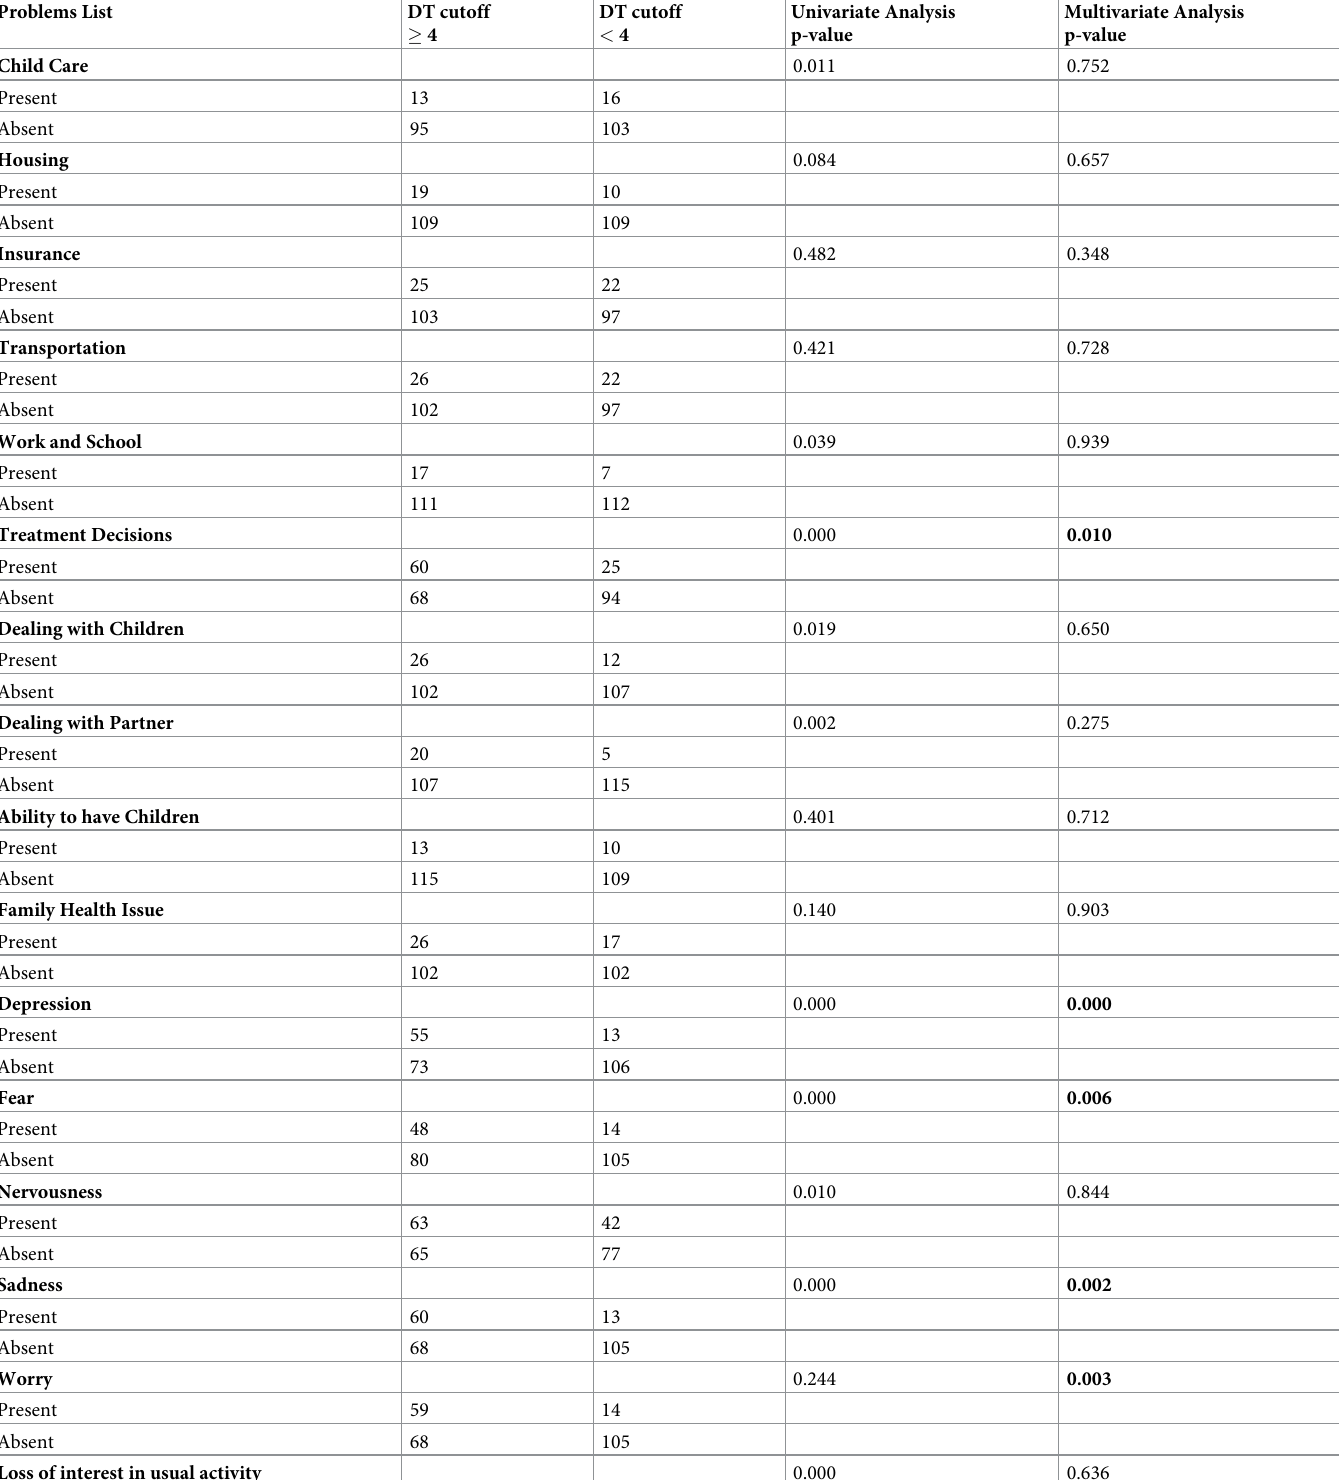
Table 3. Univariate and multivariate regression analyses of the association between the Distress Thermometer (DT) score � 4 and the Problems List items of 247 cancer